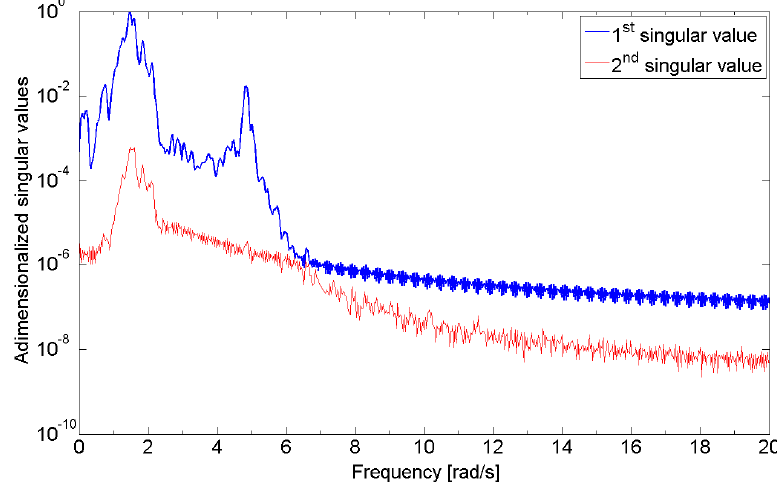
Figure 1. Typical singular value plot for a 2 ‐ DOF system.